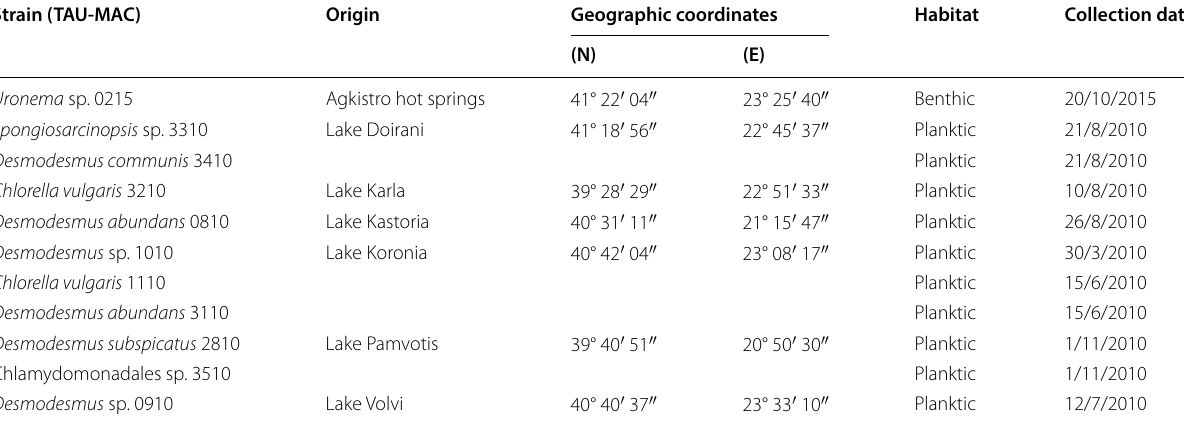
Table 1 Green algae strains isolated in this study and their origin Strain